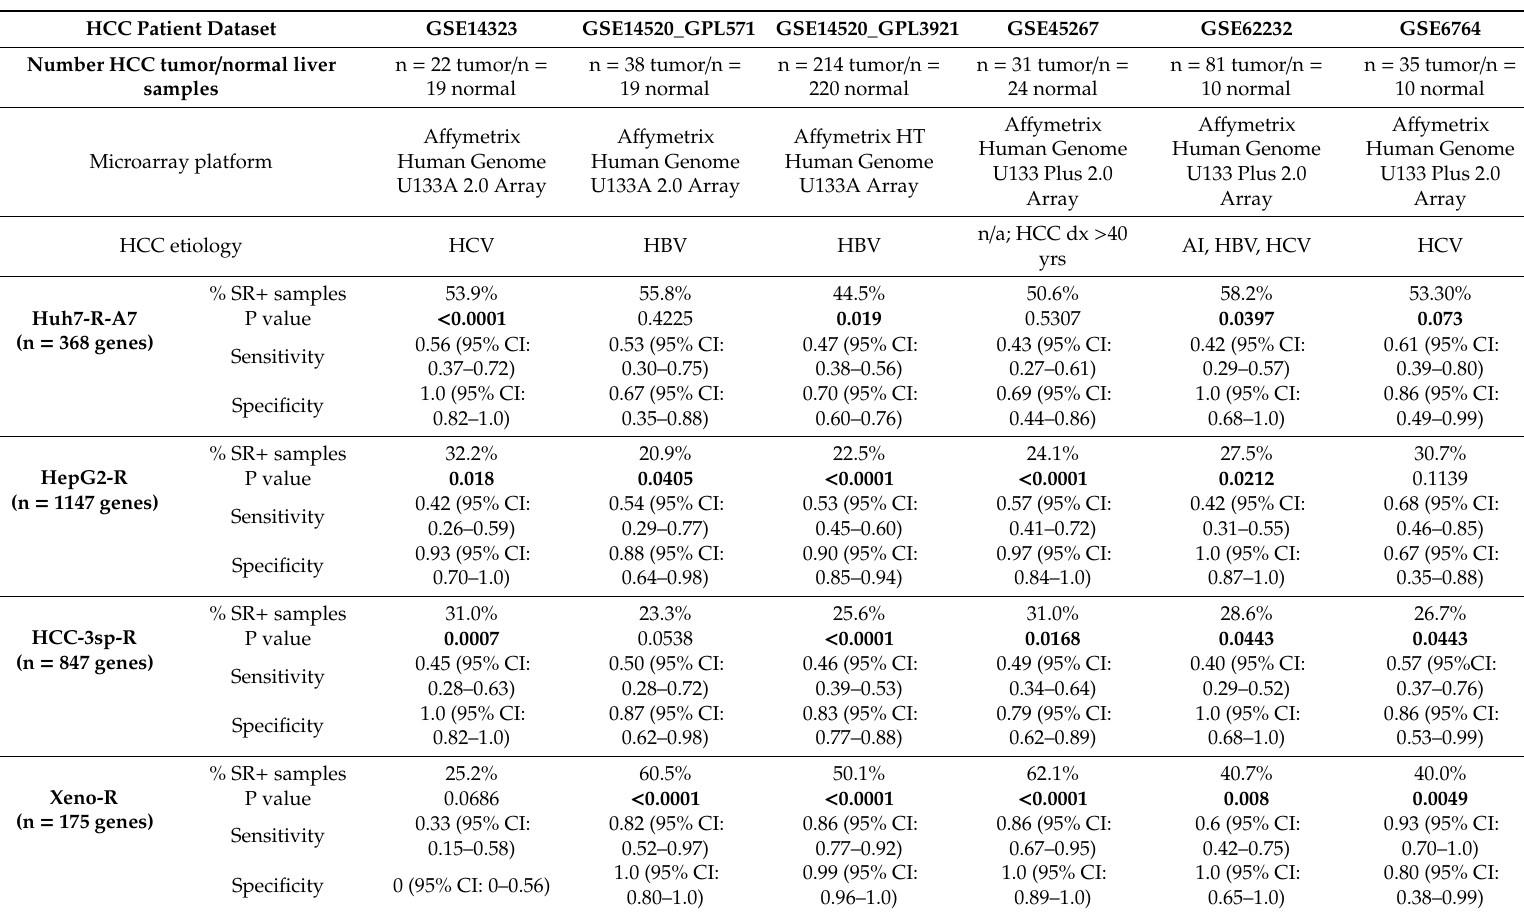
Table 1. Description of HCC patient gene expression datasets and classification of HCC tumor vs. normal liver status by sorafenib resistance gene